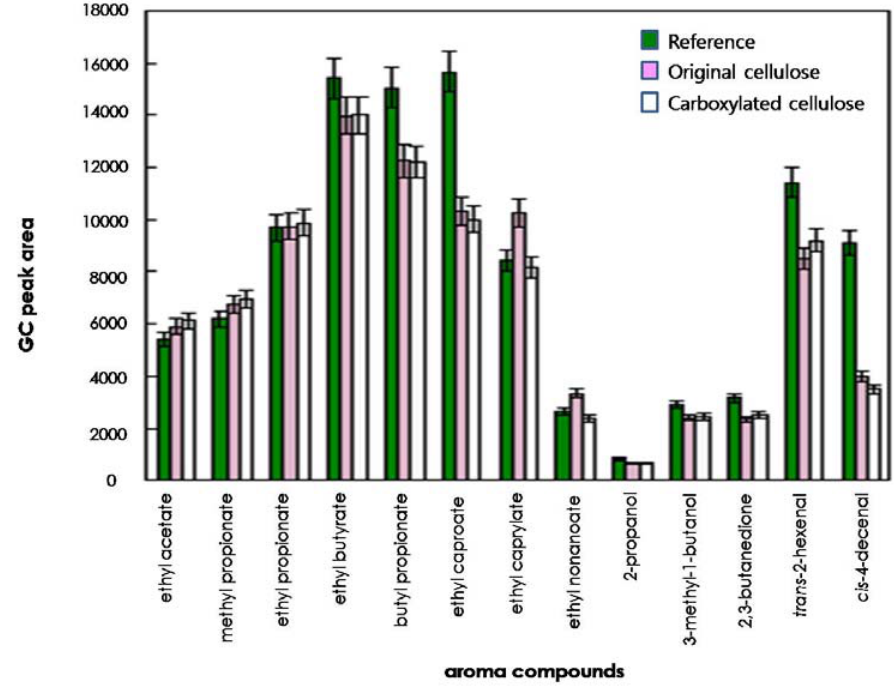
Figure 4. Comparison of release of odor compounds in hydrocolloid systems containing original or carboxylated cellulose and reference solution at pH